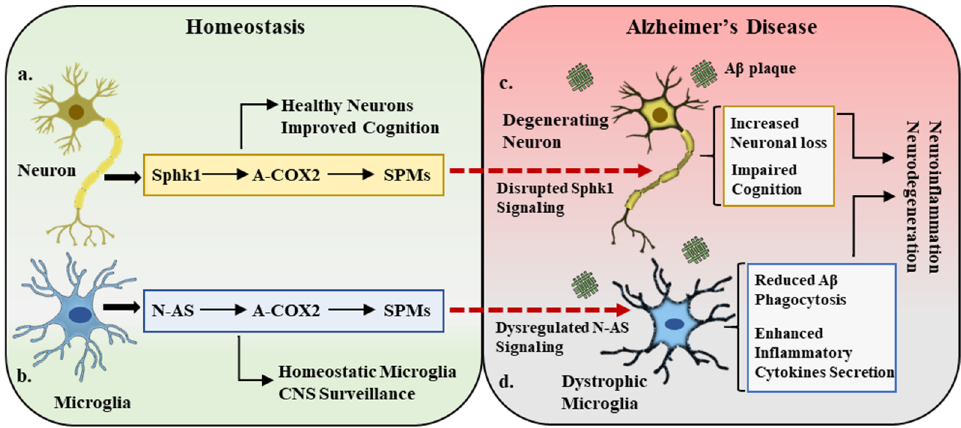
Figure 2. Sphk1–COX2–SPM trilogy in homeostasis and Alzheimer’s disease. ( a ). Under homeo- static conditions, neuronal cells express sphingosine kinase 1 (Sphk1), which is a potent regulator of COX2 acetylation (A-COX2) and subsequent SPM synthesis. This Sphk1–COX2–SPM trilogy acetylation (A-COX2) and subsequent SPM synthesis. This Sphk1–COX2–SPM trilogy maintains the maintains the central nervous system (CNS) homeostatic environment, improves cognition, and central nervous system (CNS) homeostatic environment, improves cognition, and maintains healthy maintains healthy neurons. ( b ). In a parallel manner, the microglial compartment in the CNS ex- neurons. ( b ). In a parallel manner, the microglial compartment in the CNS expresses N-AS, which also presses N-AS, which also acetylates COX2 and monitors SPM expression. This N-AS signaling maintains the microglial activity in balance and participates in CNS surveillance. ( c , d ). In Alz- in balance and participates in CNS surveillance. ( c , d ). In Alzheimer’s disease pathology, heimer’s disease pathology, amyloid beta (A β ) deposition results in the disruption of Sphk1 sig- naling in neurons and N-AS expression in microglia, leading to neuronal loss (degenerating neu-